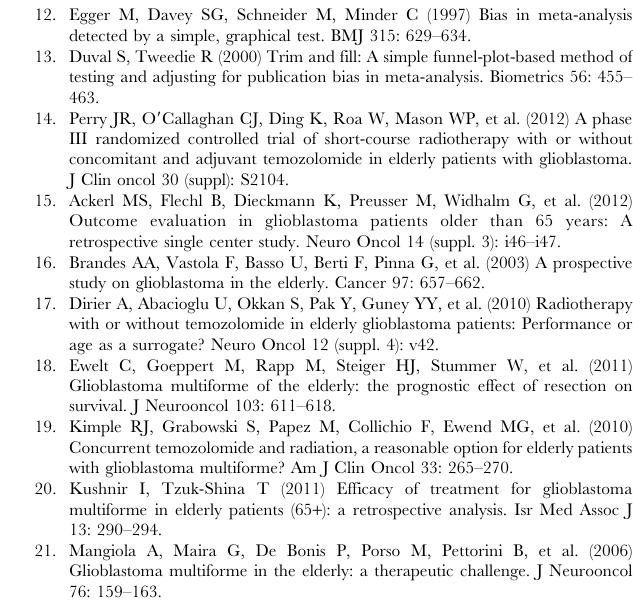
Table S1 Criteria for judgment risk of bias in the modified domain-based evaluation. Table S2 Assessment of risk of bias of